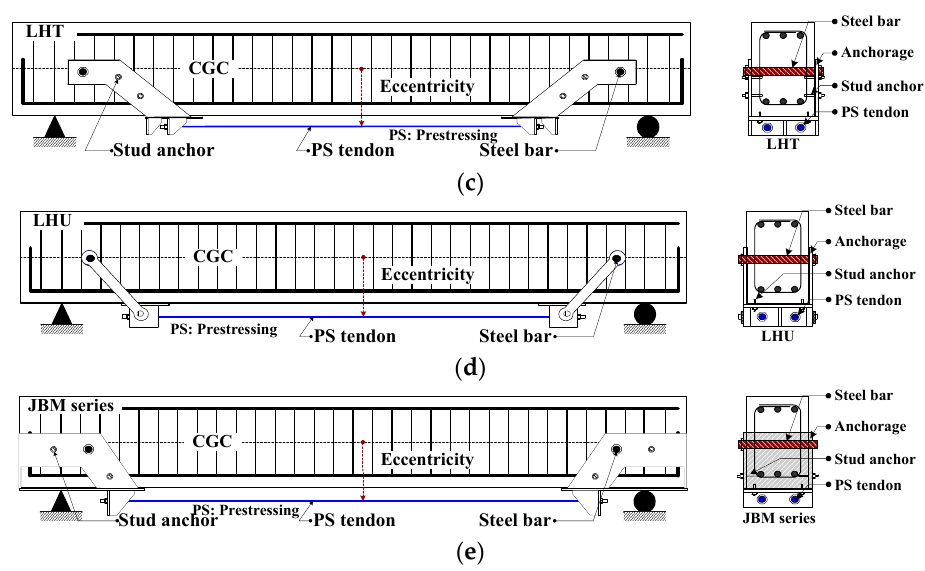
Figure 1. Beam details. ( a ) CON: the control beam; ( b ) LHS: the beam applied with the conventional anchorage Type I; ( c ) LHT: the beam applied with the conventional anchorage Type II; ( d ) LHU: the beam applied with the conventional anchorage Type III; ( e ) JBM series: the beams applied with the newly proposed anchorage.